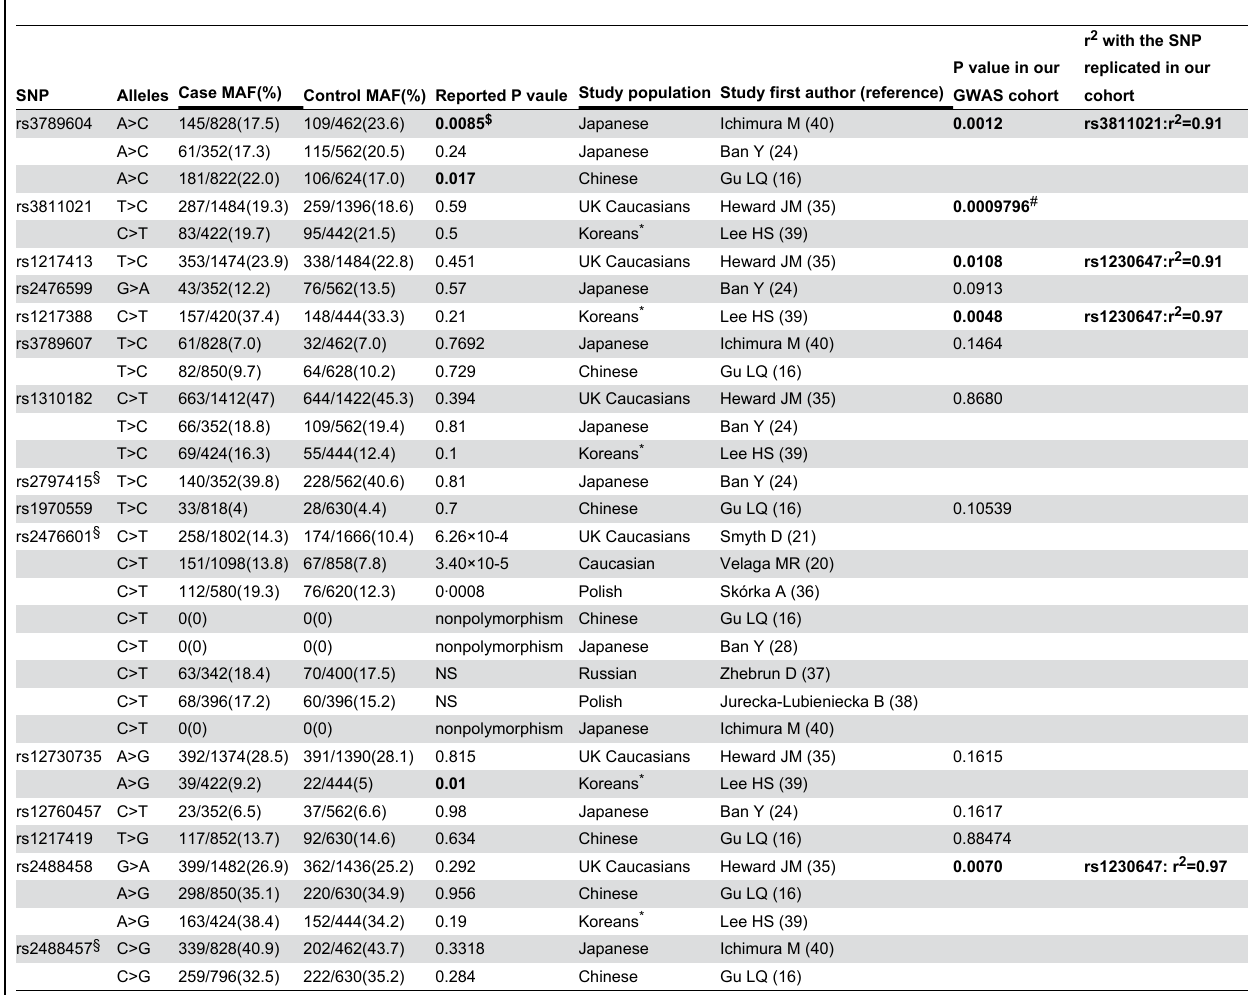
Table 3. Comparision of the association of SNPs in PTPN22 region with GD in the current study with that in previous reports.